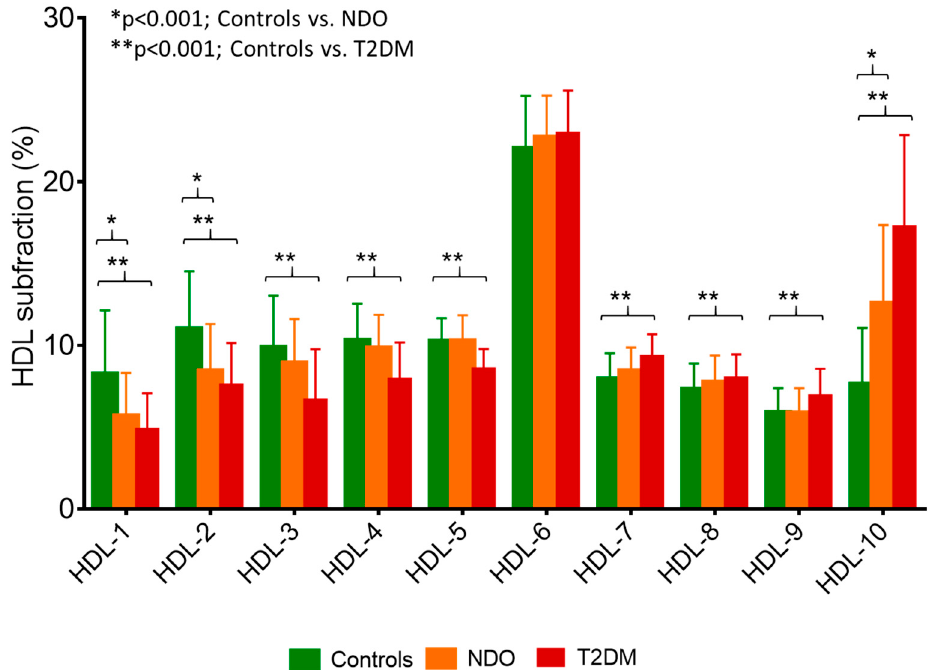
Figure 1. Percentage of high-density lipoprotein (HDL) subfractions in healthy lean subjects (controls; green bar; n = 49), non-diabetic obese patients (NDO; orange bar; n = 106), and patients with type 2 diabetes mellitus (T2DM; red bar; n = 62). Data are presented as mean ± standard deviation. Differences between the three study groups are analyzed using a one-way ANOVA. * indicates a p < 0.001 between controls and NDO; ** indicates a p < 0.001 between controls and T2DM. HDL subfractions were distributed by Lipoprint gel electrophoresis (Quantimetrix Corp. Redondo Beach, CA, USA) from peripheral blood serum